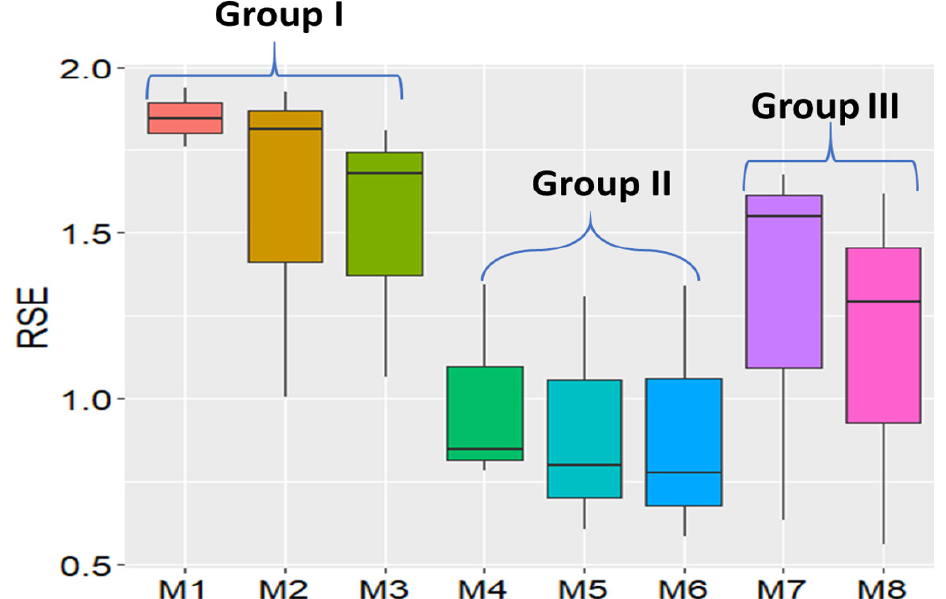
Figure 10. Boxplot of the residual standard error (RSE). The Y -axis is the residual standard error. The first three boxplots from the left belong to Group I, the middle three belong to Group II, and the two from the right belong to Group III. Table 10. Results of pairwise t-test of the group mean.